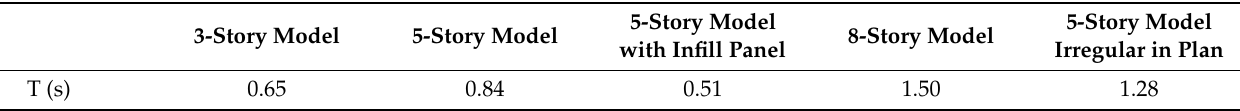
Figure 6. Infill model used for the nonlinear numerical analyses: ( a ) constitutive model of the infill panel related to Mainstone model (u represents the elastic limit displacement); ( b ) equivalent diagonal struts scheme. Table 1. Fundamental periods of vibration of the numerical models representing the structures under consideration.